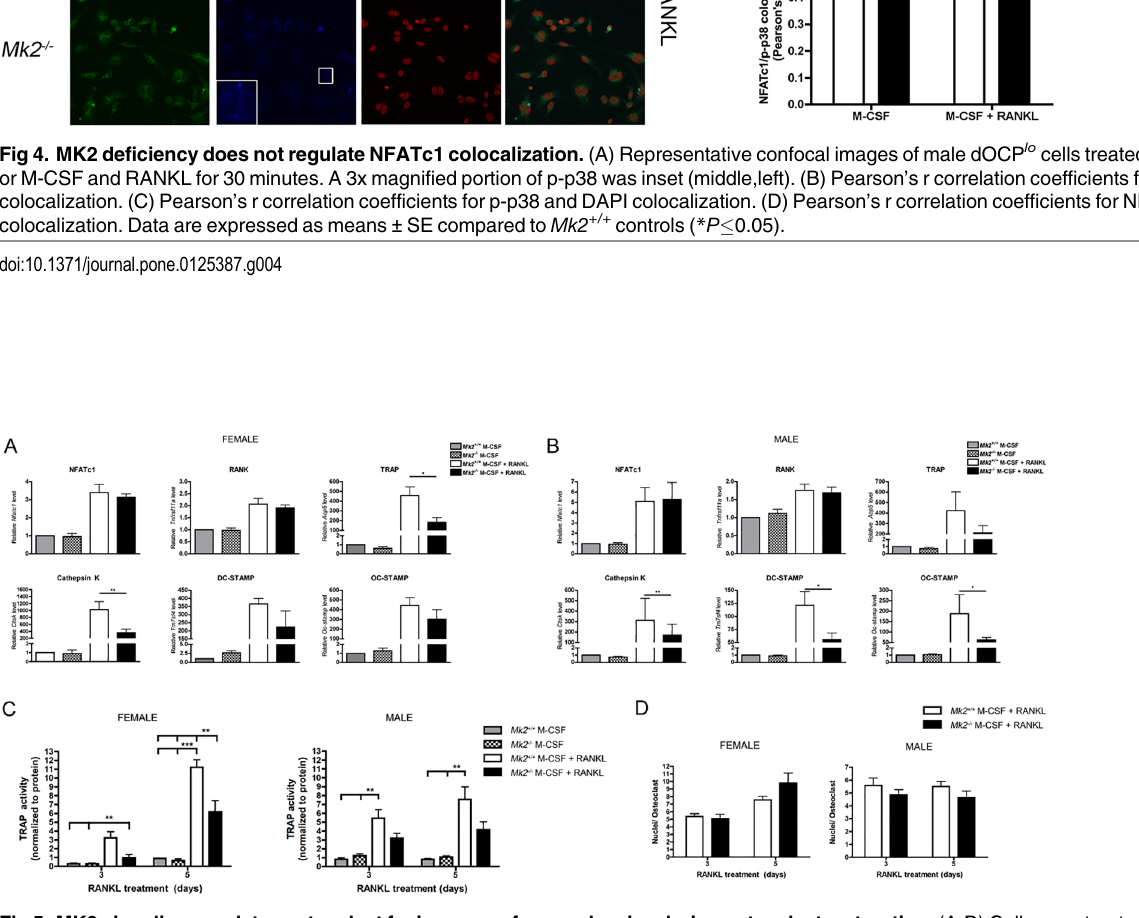
PLOS ONE | DOI:10.1371/journal.pone.0125387 May 6,